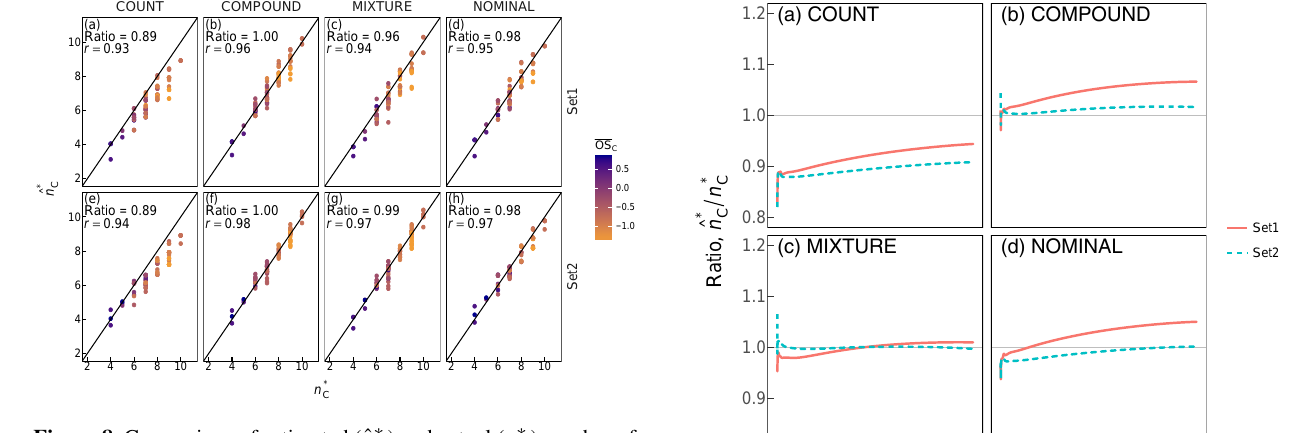
) and actual ( n ∗ ) number of C C Figure 9. Ratios of estimated ( ˆ n ∗ surable carbon atoms in the APIN simulated aerosol mixture using regressed C estimates of ˆ λ C for various FG sets and solution methods. The gray horizontal line corresponds to y = 1 . 0 (perfect